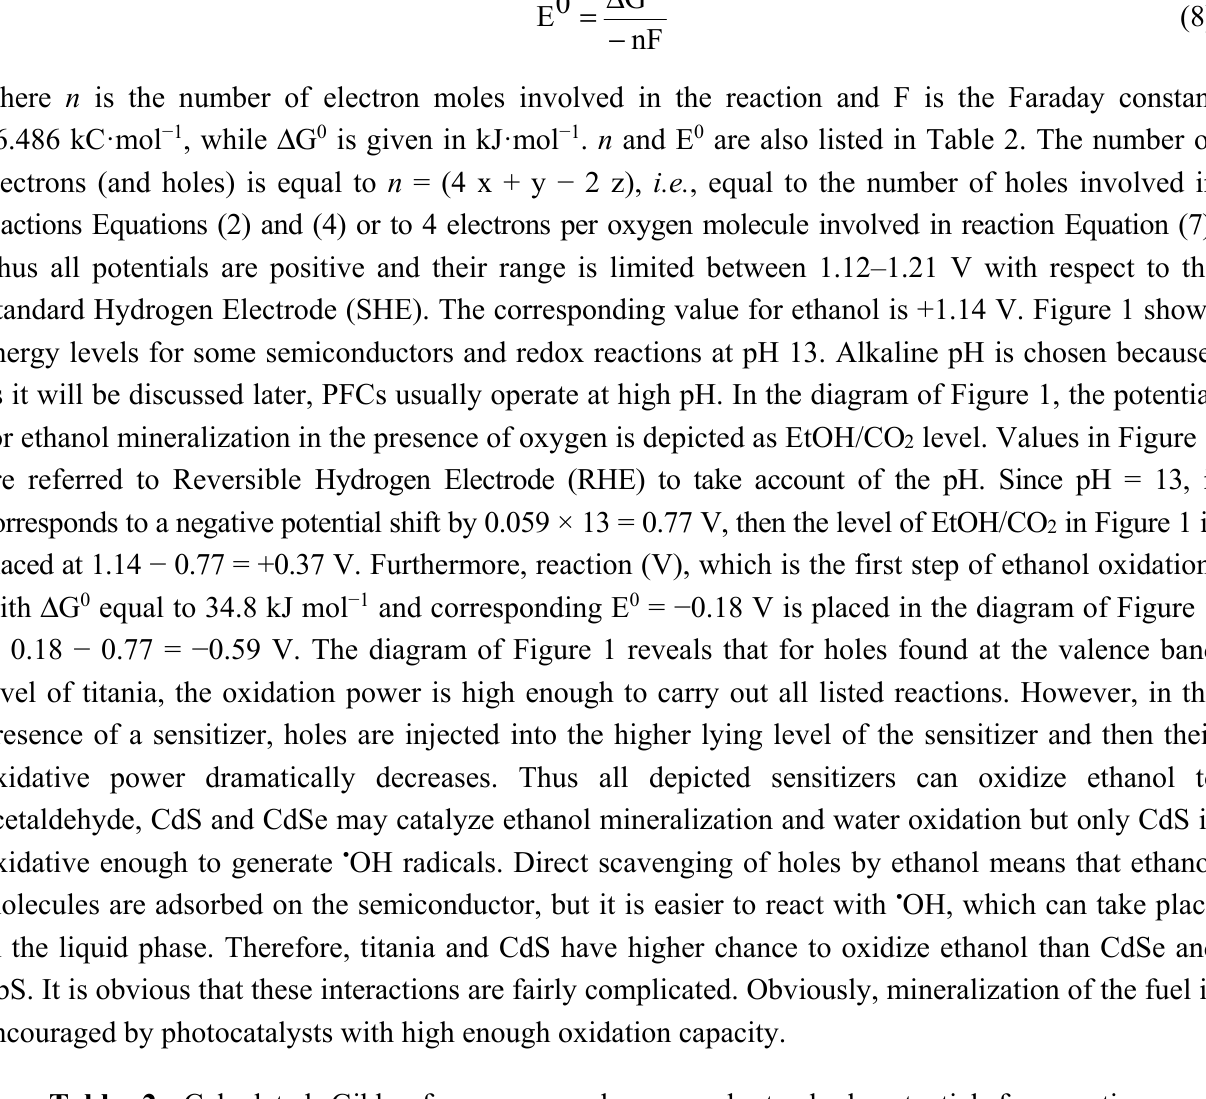
Table 2. Calculated Gibbs free energy change and standard potential for reaction Equation (7) and for a few organic substances of the general composition C x H y O z